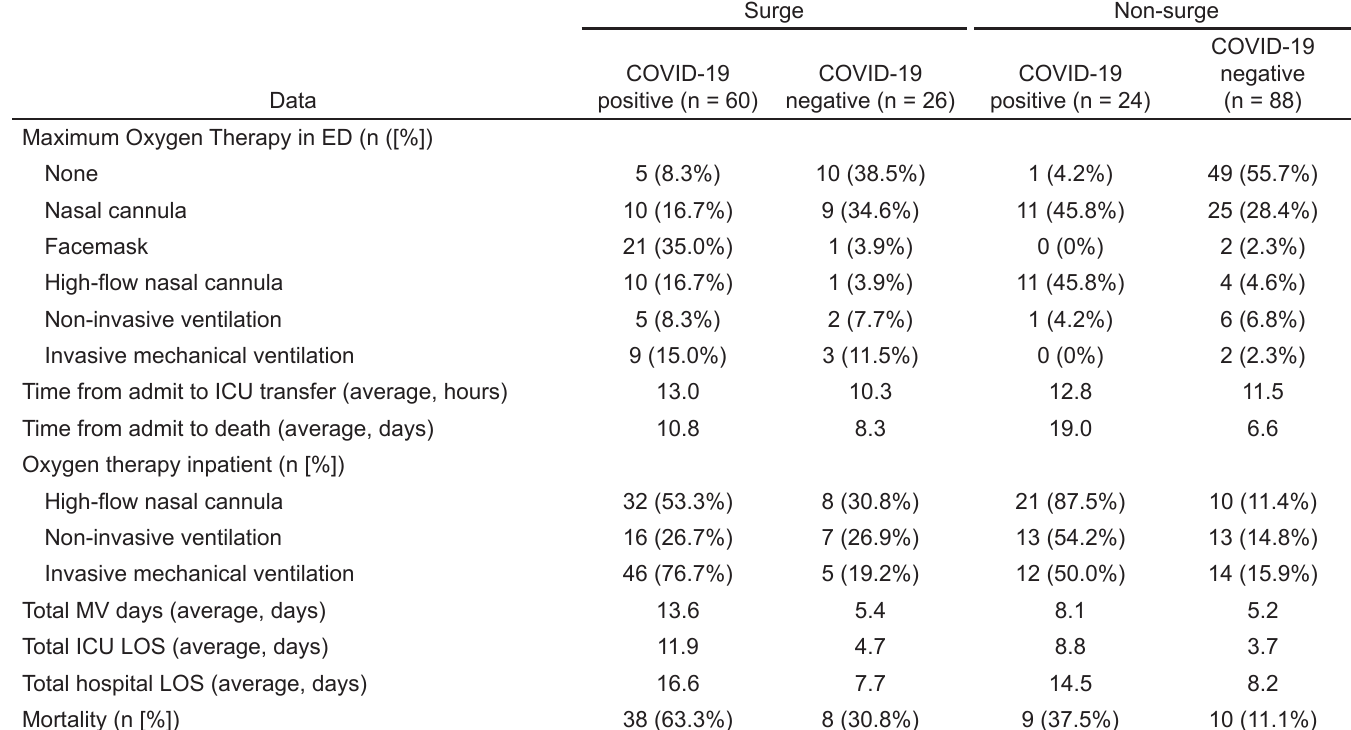
Table 2. Description of therapies administered and patient outcomes.